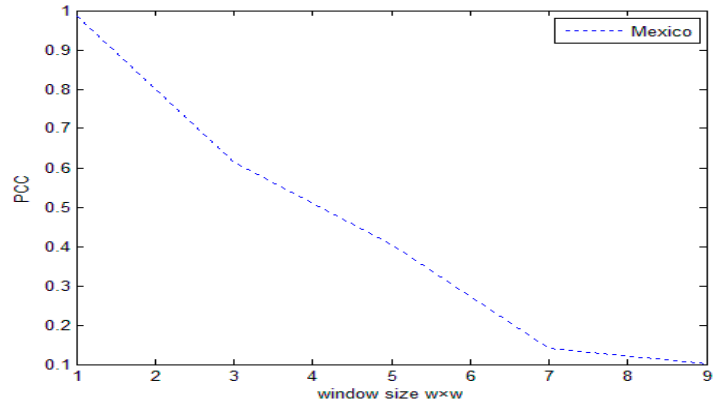
Figure 7. The relationship between window size ω × ω and PCC.